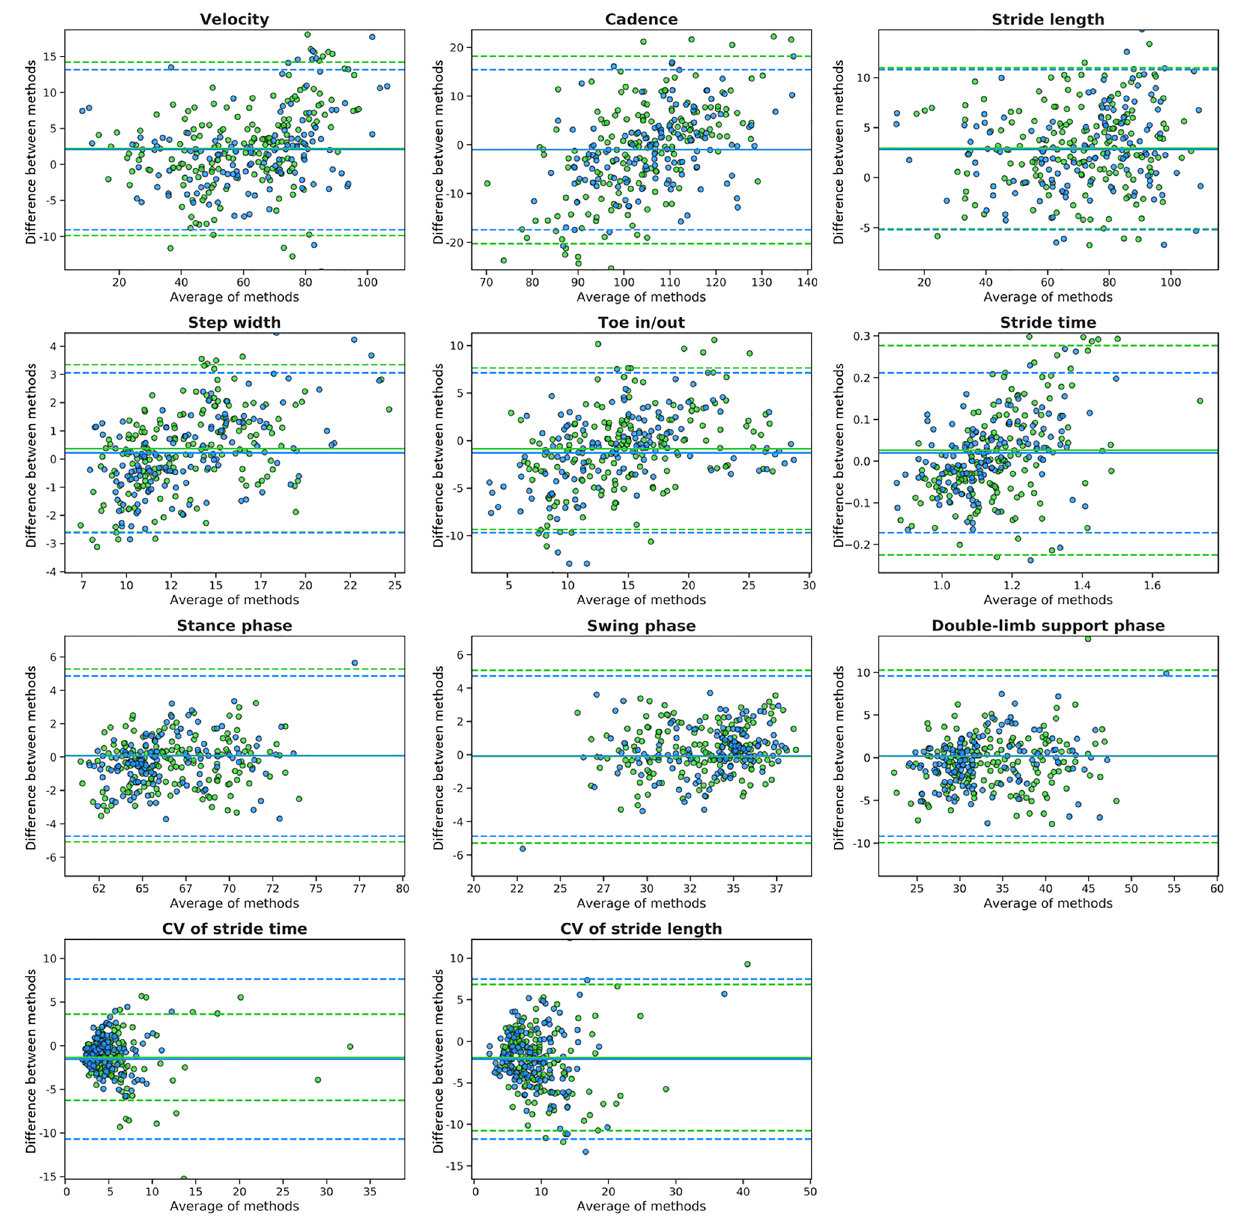
Figure 2. Agreements between the vision-based gait analysis system and the GAITRite gait analysis system for all parameters. Bland–Altman plot of all gait parameters measured by the two measurement systems before and after the CSFTT. Straight and dashed lines indicate mean differences and 95% limits of agreement, respectively. Green color indicates data before the CSFTT while blue color indicates data after the CSFTT. CSFTT, cerebrospinal fluid tap test; CV, coefficient of